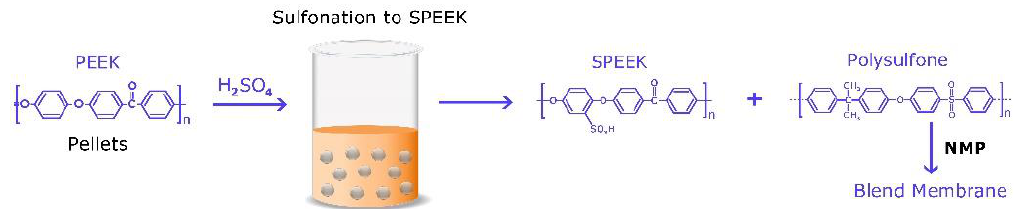
Figure 3. Fabrication of the blended polymeric